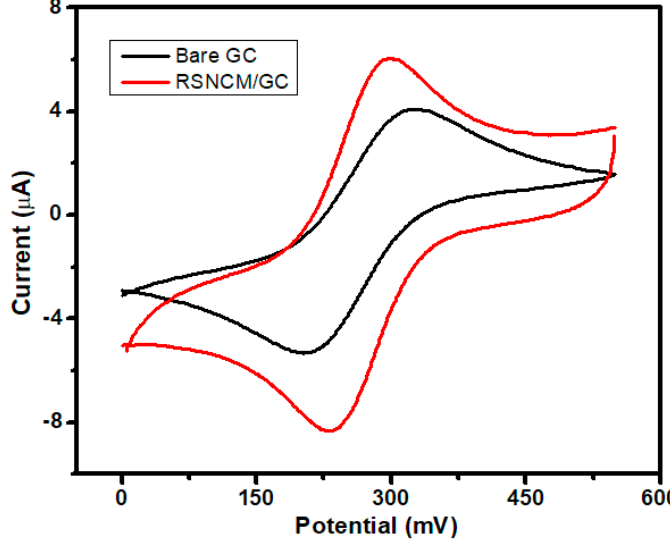
Figure 5. CVs obtained for a RSNMC/ glassy carbon (GC) and bare GC electrode in 1.0 mM K 3 Fe(CN) 6 prepared in PBS, pH 7.0 at scan rate of 20 mV/s.